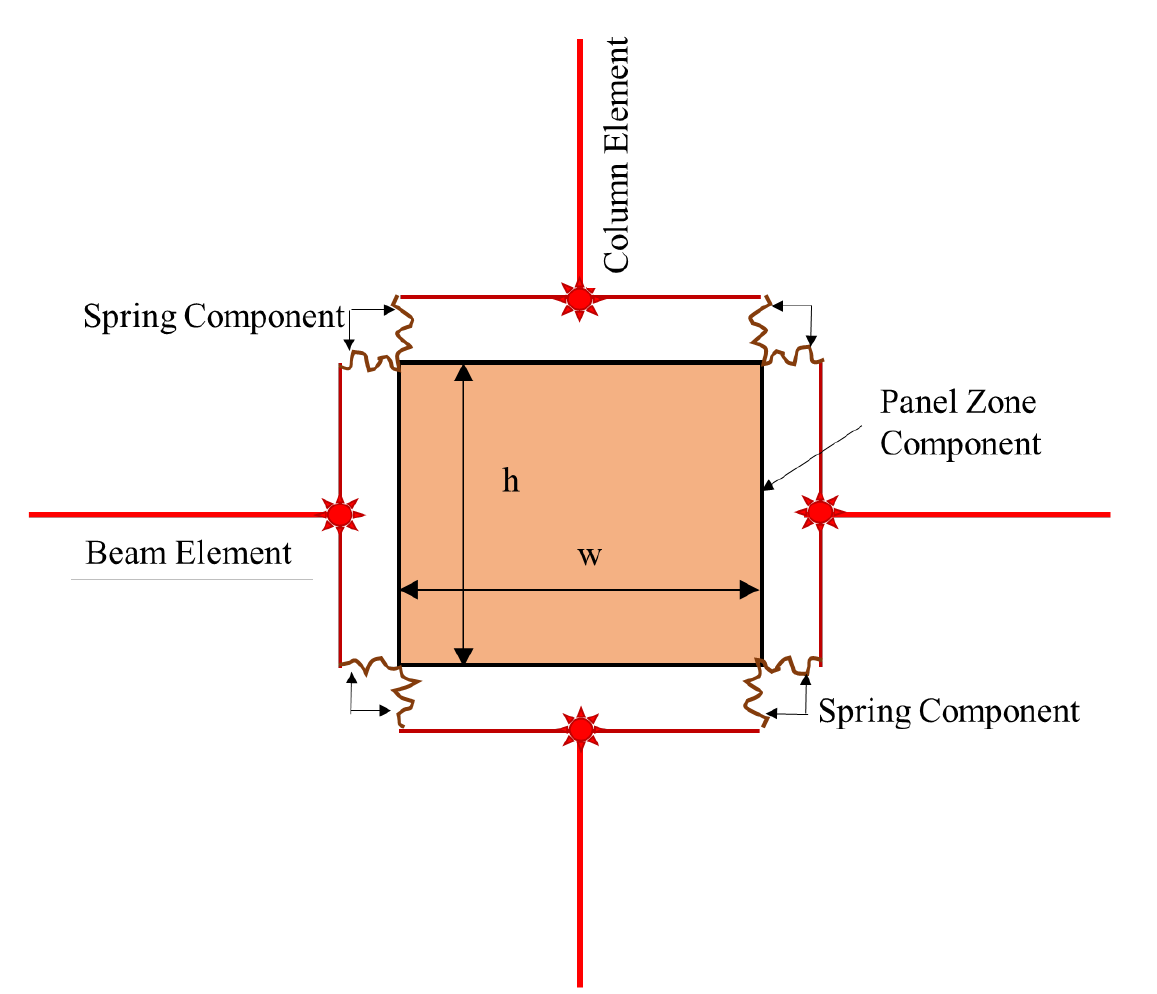
Figure 13. Joint element with eight linear and rotational springs and a central joint panel component to capture interface and panel shear along with bar–slip mechanism, reproduced from literature [74].